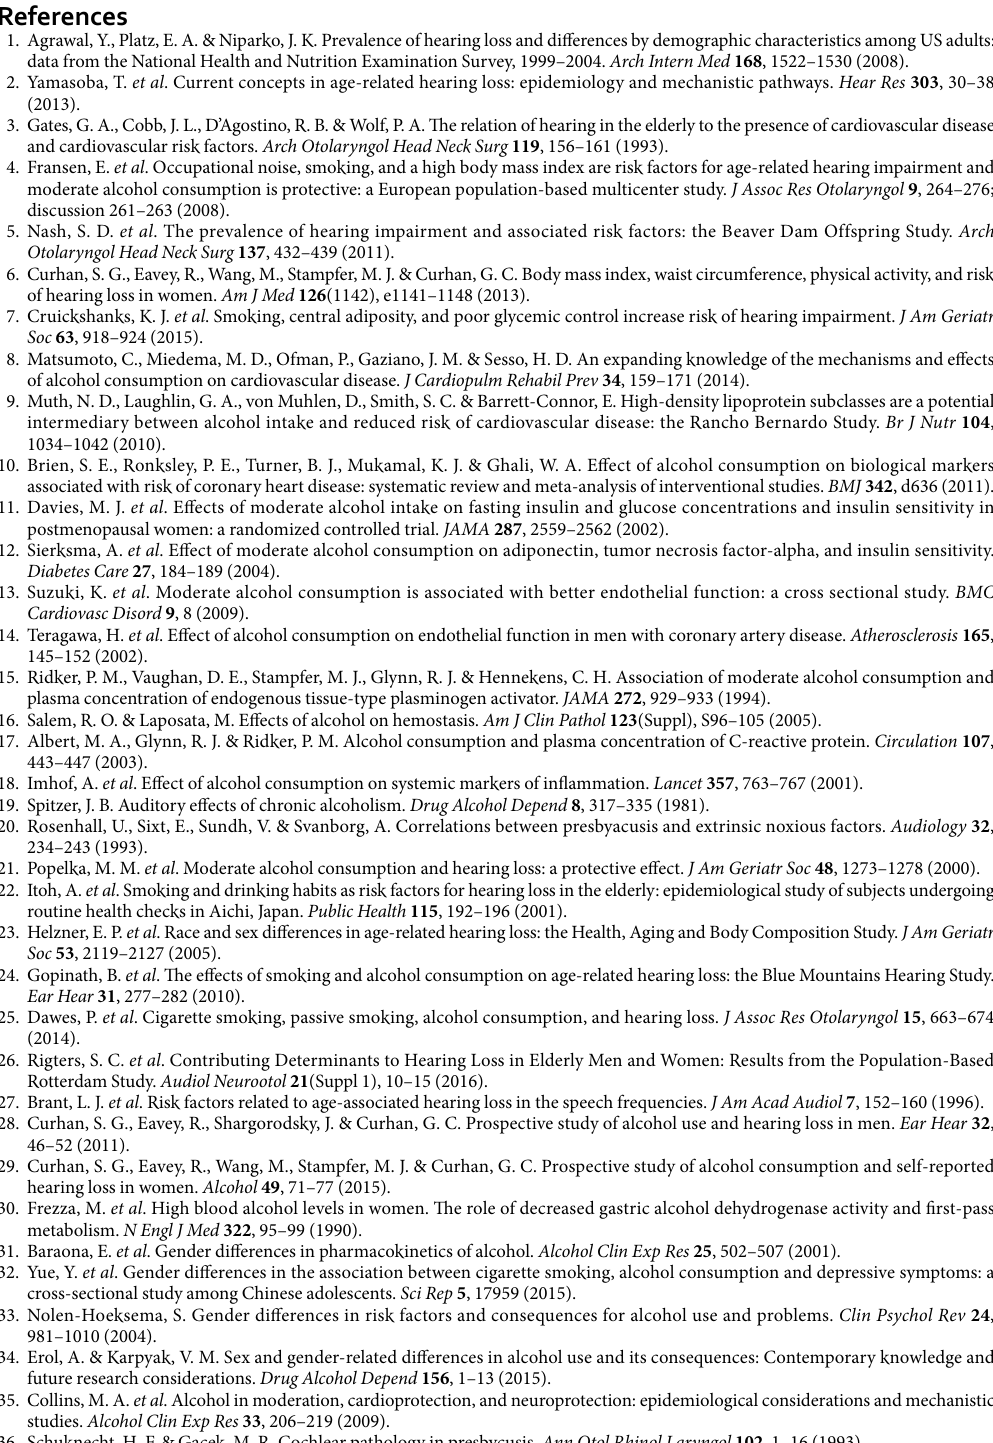
referent group. The linear regression model was used to evaluate the effect of patterns of alcohol consumption on the hearing threshold. A multiple-model analysis was performed for adjustments of covariates 41 . First, age, gen- der, and race were adjusted in model 1. Model 1 subsequently adjusted for waist circumference, uric acid, fasting glucose, and total cholesterol was model 2. Model 2 further adjusted for abnormal otoscopy and tympanometry, current use of ototoxic medication, history of diabetes, heart disease and stroke was model